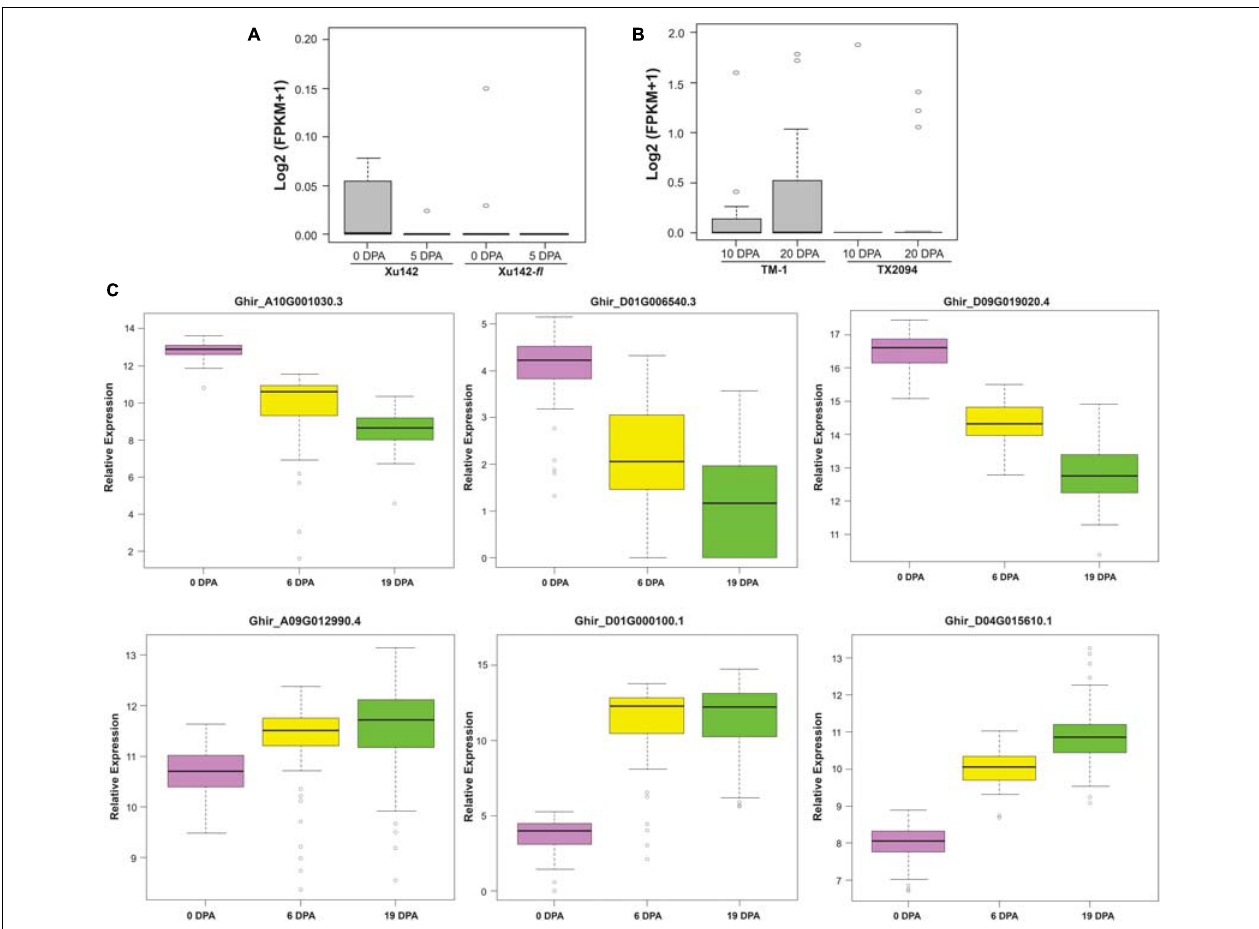
FIGURE 6 | Validations of Exclusively Expressed Transcripts (EETs) through RNAseq expression profiling and nCounter assay. (A) the in silico expression pattern of twenty EETs for the fiber-specific pattern in wild cotton (Xu142) and fuzzless natural mutant (Xu142 fl ) at 0 DPA and 5 DPA as well as (B) for the domestication process in modern-day cotton (TM-1) and wild cotton (TX2094) at 10 and 20 fiber developmental stages. (C) Nanostring based nCounter gene expression assay of six selected transcripts at 0, 6, and 19 DPA fiber developmental stages in 100 cotton genotypes growing at the 2018 growing season at Hyderabad city of